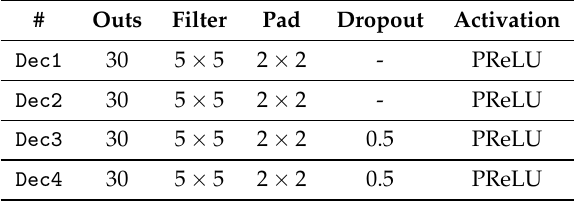
Table 2. All the experiments (namely, MF4 , AF4 , and AF5 ) related to the general architecture of the autoencoder, which is shown in the Figure 2, use the same layout of the decoder part. This table includes a detailed layout of the convolutional layers and the activation functions used in the decoder, such as PReLU [35]. The rows of the presented table describe consequent layers of the decoder CNN, denoted as Dec1 – Dec4 .